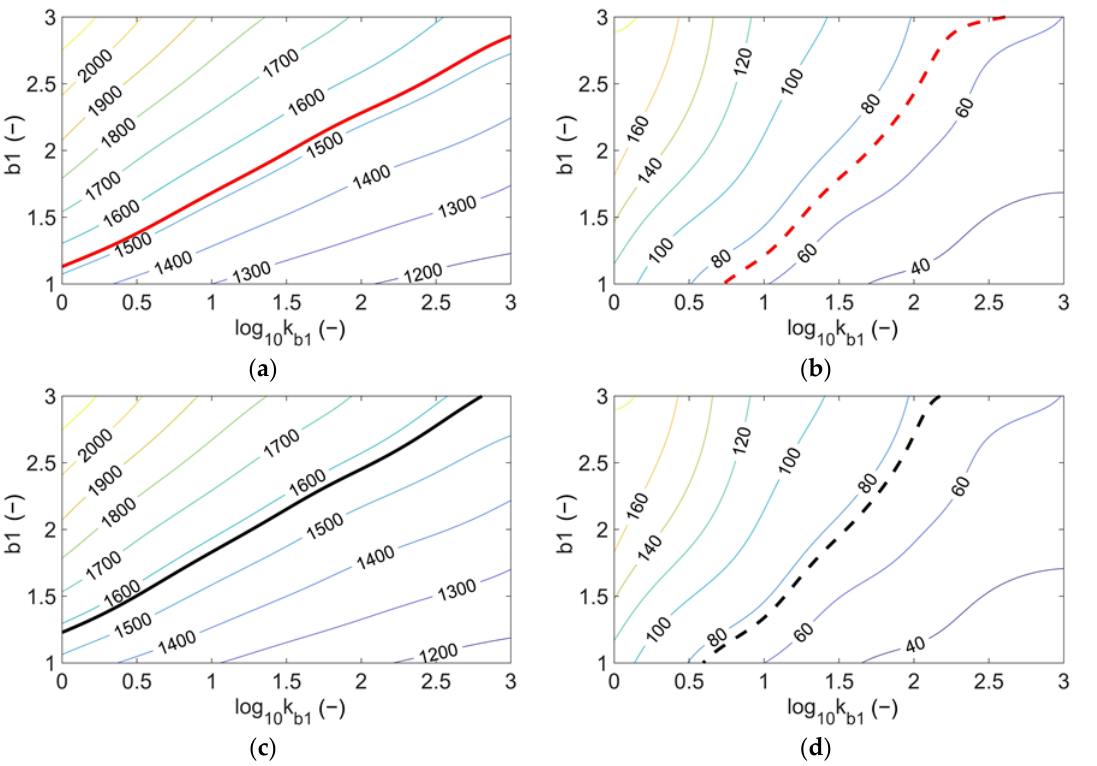
Figure 6. The outline of a mapping of the kinetic parameters to: ( a ) the mean of the latent periods at j’ = 1, ( b ) the standard deviation of the latent periods at j’ = 1, ( c ) the mean of the latent periods at j’ = 2, and ( d ) the standard deviation of the latent periods at j’ = 2.